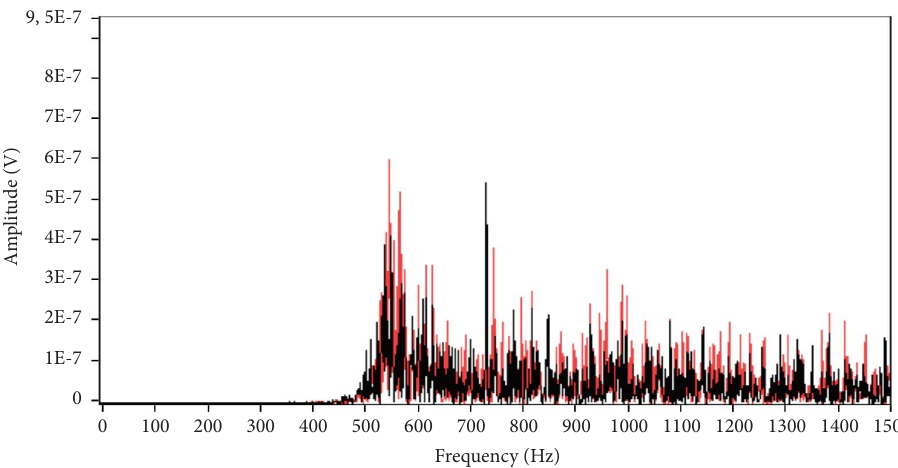
Figure 4: FFT peaks in the Doppler spectrum, no UAS present (noise